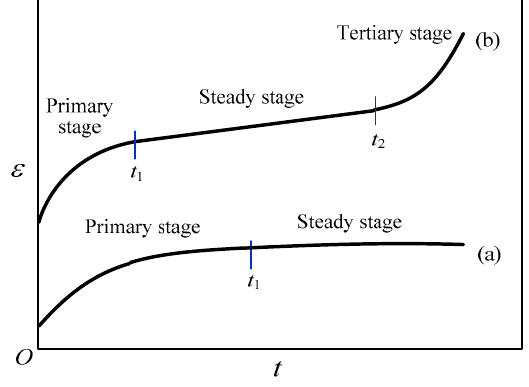
Figure 3. Schematic of creep curves of asphalt mixture.